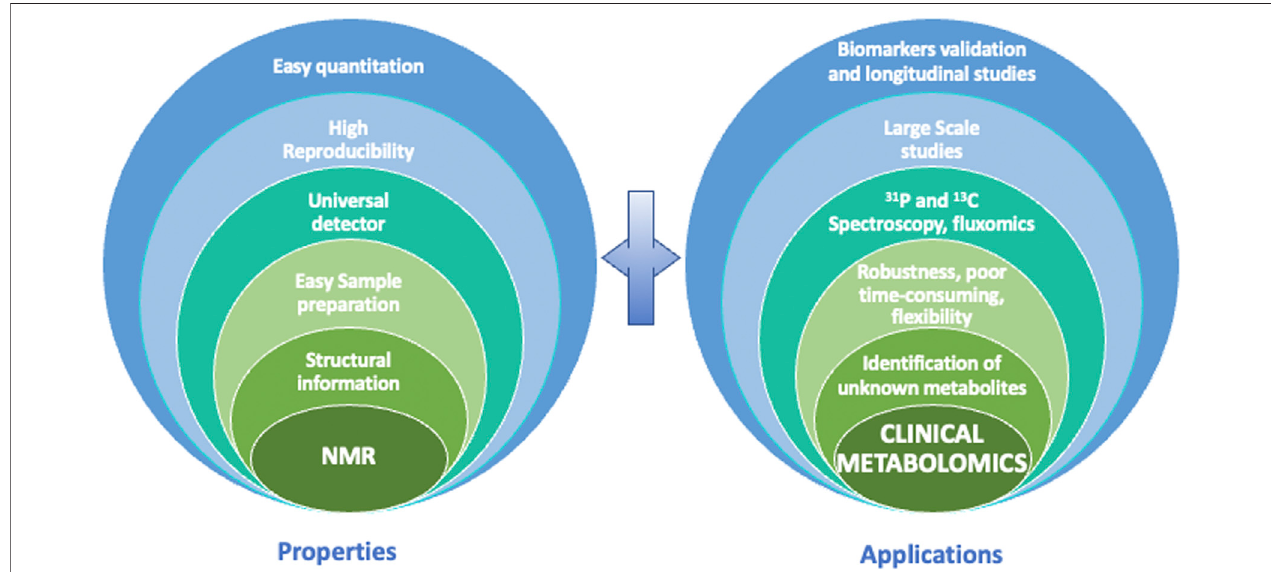
FIGURE 3 | Properties of NMR that allow speci fi c advantages for clinical